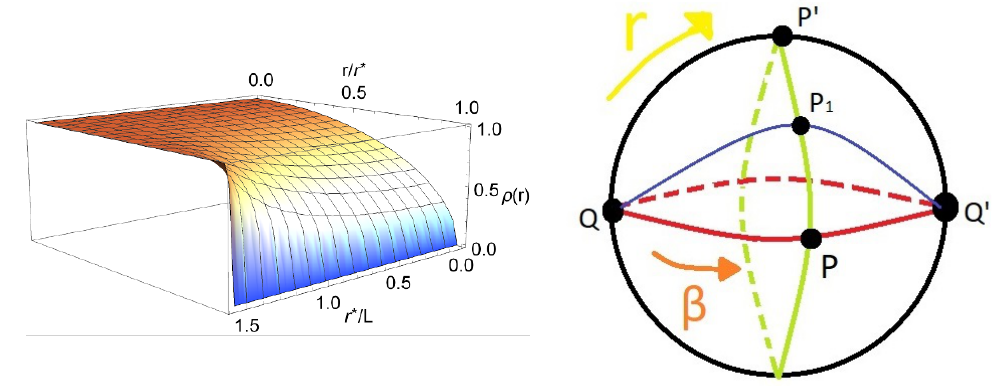
Figure 1 . Left: solution for (cid:26) ( r ) in dependence of r ? . Right: geometric interpretation of the analytical solution eq.